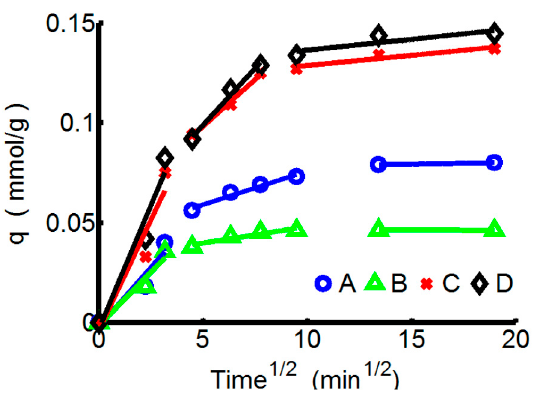
Figure 4. The kinetics curves of ChW and PTW based on the Weber-Morris pattern. ( A ) ChW-Cu 2+ ; ( B ) ChW-Pb 2+ ; ( C ) PTW-Cu 2+ ; and ( D ) PTW-Pb 2+ .